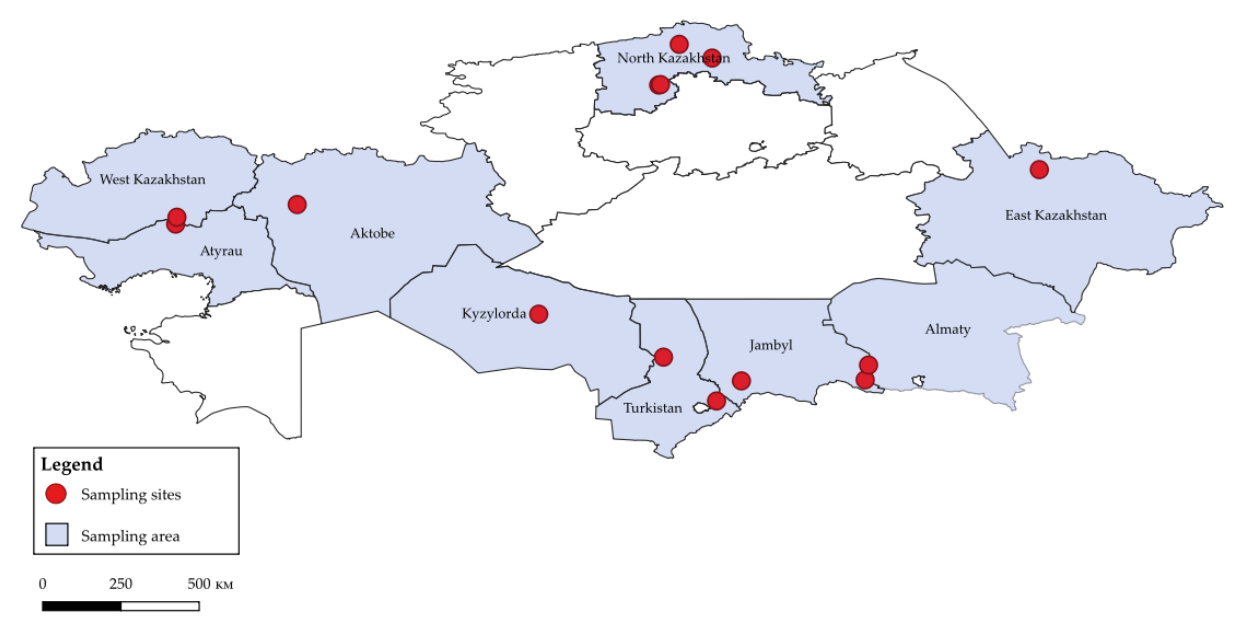
Figure 1. Map of Kazakhstan with bats sampling sites. Bat trapping and sampling were carried out in old, abandoned buildings, on rooftops, in an old tunnel, and in a cave. The Batbox Baton Bat Detector (NHBS, London, U.K.) ultrasonic detector series D 100 was used to locate the bats. Bats in tunnels or caves were caught with mist nets, and bats inhabiting abandoned buildings and rooftops were caught using anatomical tweezers. Guano and oropharyngeal swabs were collected in each colony, and several individuals were taken for brain sampling. Swabs were taken from all captured bats. Some of these animals were seized for brain sampling. To do this, we seized